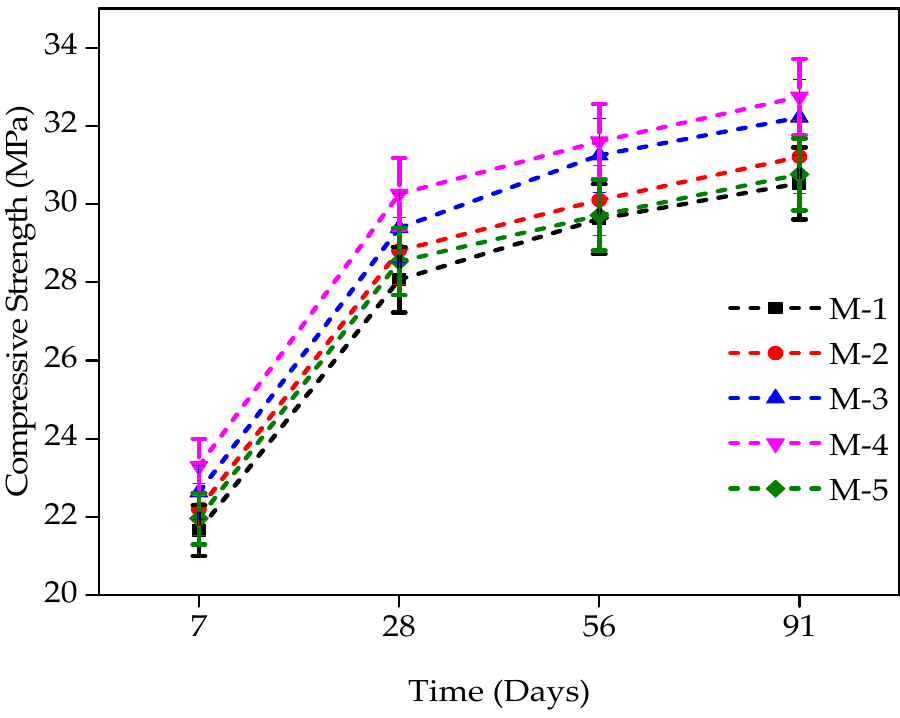
Figure 4. Compressive strength development of WFS concrete at various ages [47].